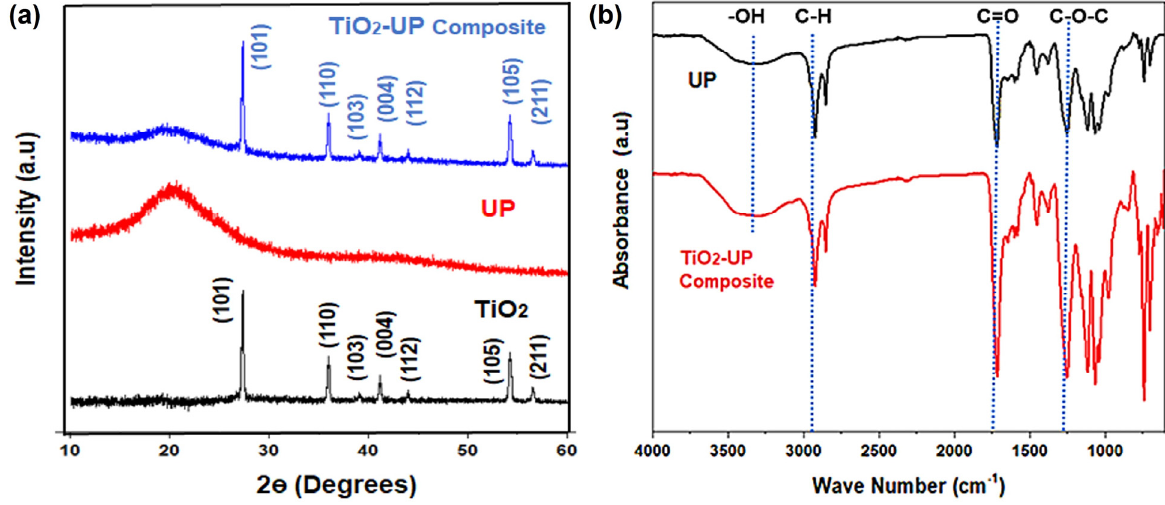
Figure 3. Comparison of ( a ) XRD Spectra and ( b ) FTIR spectra of unsaturated polyester (UP) resin and TiO 2 − UP composite.